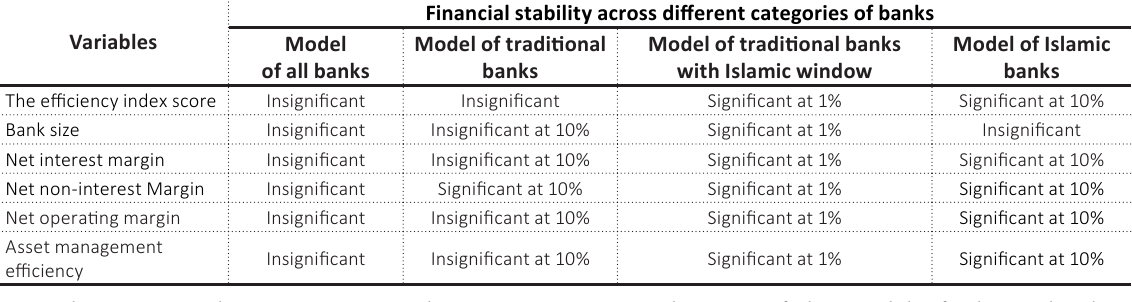
Table 15. Results summary of the statistical